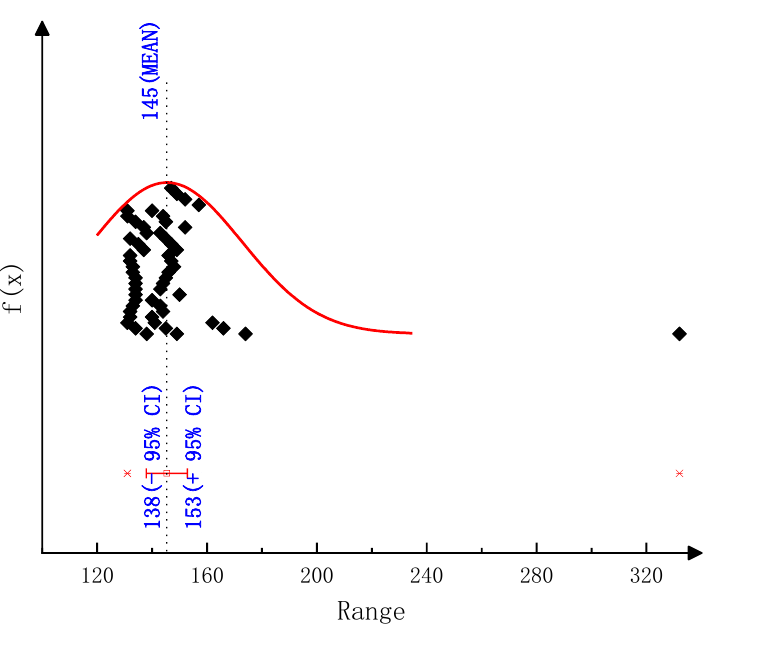
Figure A5. 95% confidence interval for the activation energy E O of CYA pyrolysis reaction.